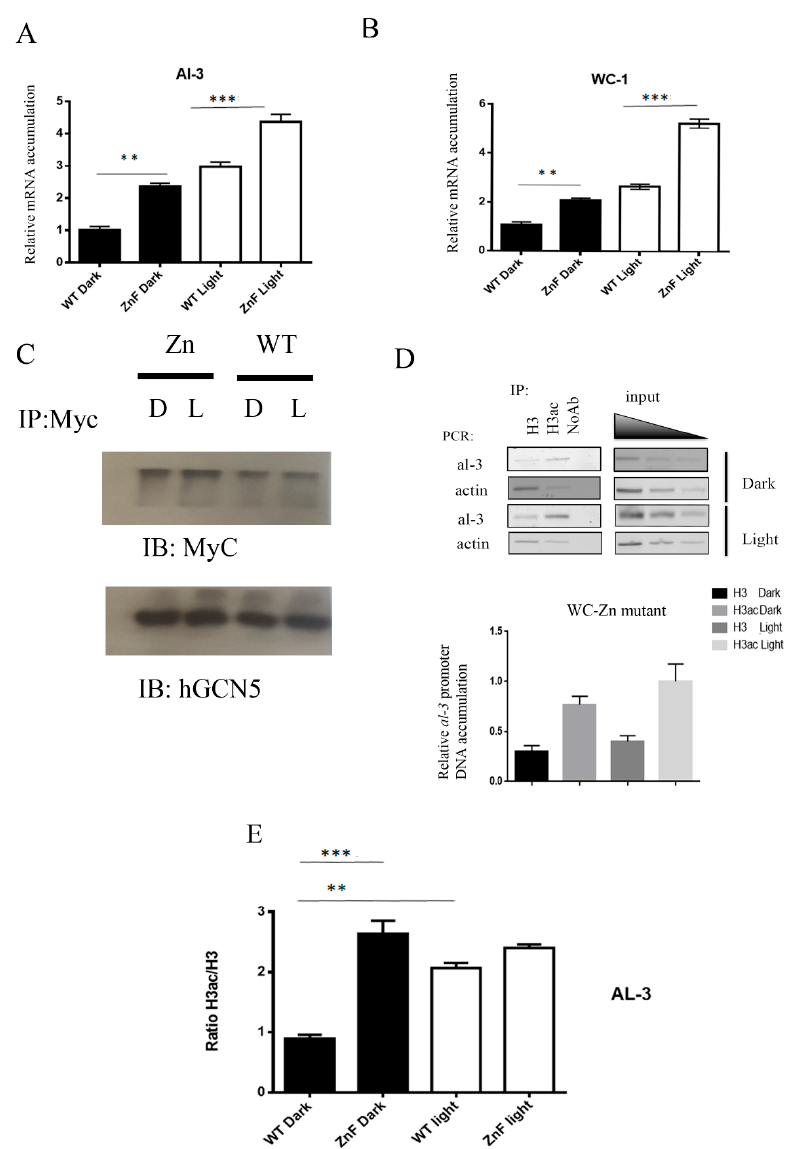
Figure 4. Zinc finger deletion influences increased RNA accumulation and histone acetylation of light-dependent genes in the dark. RNA abundances of al-3 ( A ) and wc-1 ( B ) were measured using real-time PCR in the littermate wt, and zinc finger deleted mutant strains, kept either in the dark or after illumination (light 5 min, dark 20 min for a total of 25 min after the light pulse). Data showed a different biological replica that was plotted on a graph with the mean ± S.E.M. from three different experiments. Two-way Anova, Bonferroni: ** p -value < 0.05. ( C ) WC-1 was immunoprecipitated using a commercial anti-Myc antibody, and the coresolution of NGF-1 was detected using hGCN5 antibody either in wt WC-1 Myc or WC-1 Myc ZnF ∆ mutant. Immunoprecipitation was performed starting from 400 µg of mycelia grown for 3 d in the dark before harvesting or exposed to saturated light (as in ( A ) and ( B )). ( D ) A ChIP assay was performed on extract obtained from mycelia grown for 3 d in the dark before harvesting or exposed to saturated light. Anti-H3 and anti-H3-acetylated were used for immunoprecipitating the chromatin. PCR was performed on the free DNA after decrosslinking and further purification. Input: three different dilutions of total input were used for PCR amplification (1 / 4, 1 / 8, and 1 / 16). PCRs were finally quantified by densitometry and plotted on a graph. The data are the mean ± S.E.M. from three independent biological experiments (lower panel). ( E ) H3ac / H3 ratio was measured in wt and zinc finger strains, and data were plotted on a graph to compare accumulation of acetylated form of H3 in both strains in both environmental conditions (dark, light). The plotted data were obtained from three different biological replicas. Two-way Anova, Bonferroni: ** p -value < 0.05; *** p <